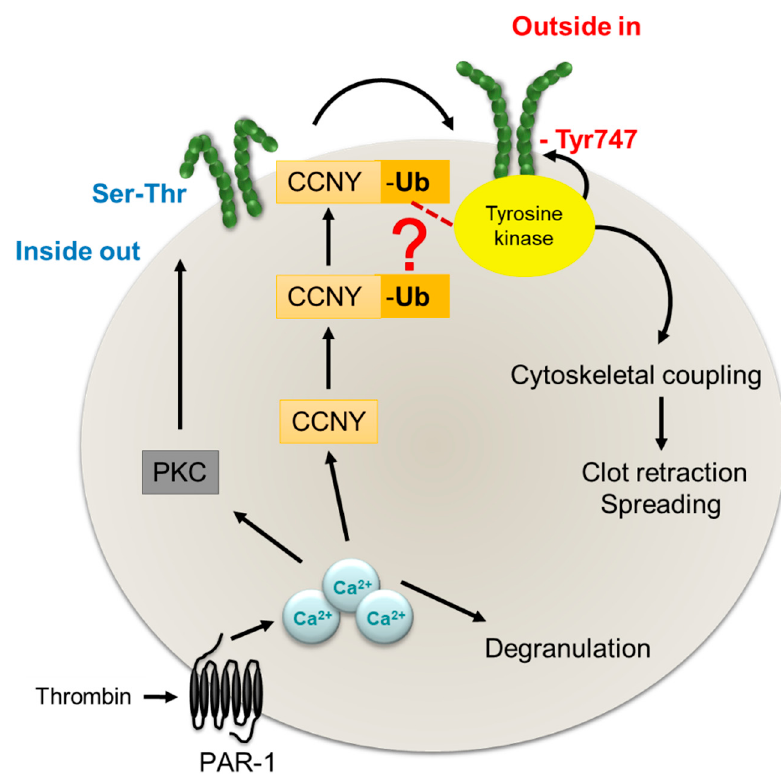
Figure 5. Role of CCNY in β 3-integrin-mediated outside-in signaling: CCNY is expressed in human and murine platelets. Stimulation of platelets with thrombin leads to the mono-ubiquitination of CCNY and its translocation to the plasma membrane where it regulates β 3 integrin tyrosine phosphorylation and outside-in signaling. Arrows represent defined processes and dotted arrow shows possible